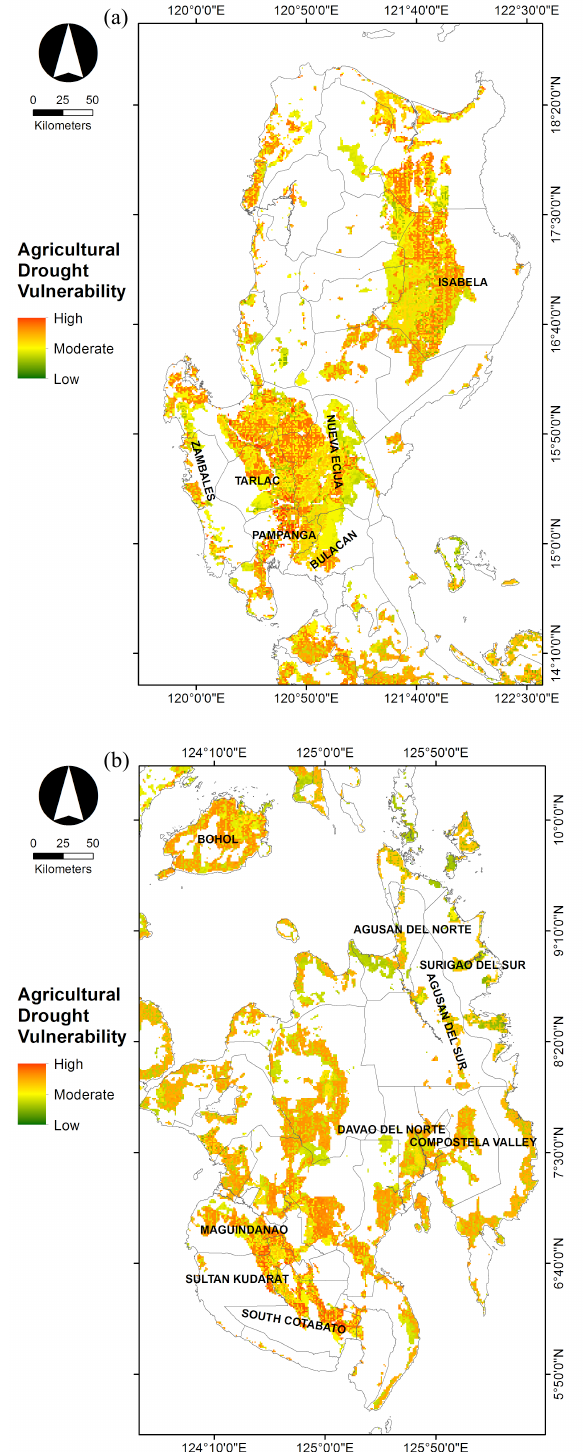
Table 1. Numerical weighing scheme used to develop the Philippine Agricultural Drought Vulnerability Map Figure 3. Agricultural drought vulnerability in some parts of (a) Cagayan Valley and Central Luzon and (b) Bohol and